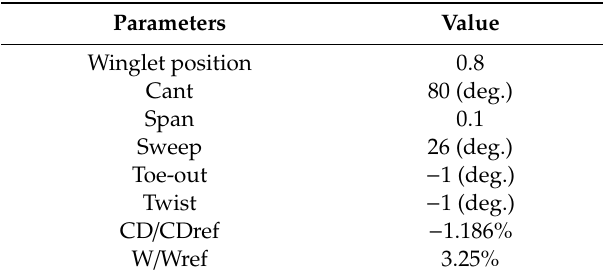
Table 11. Optimal winglet parameters.